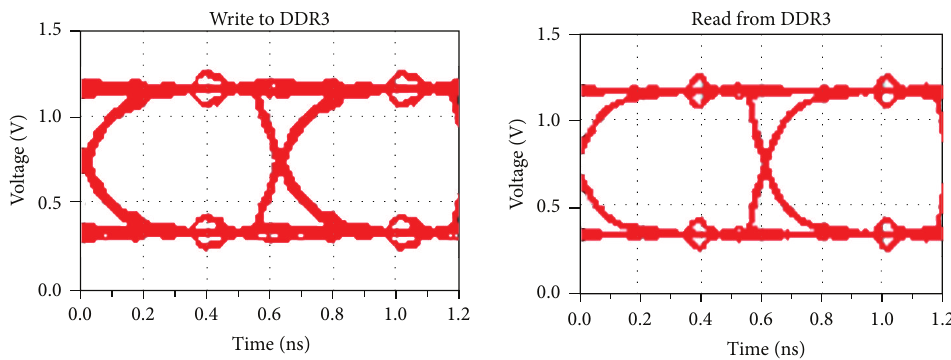
Figure 9: Simulation eye diagram for the method of